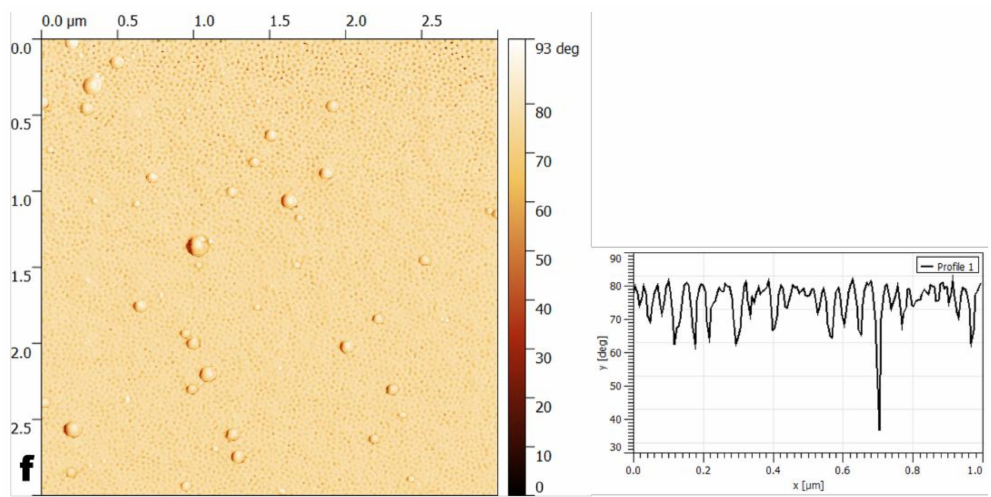
Figure 5. AFM images (3 µ m × 3 µ m) and corresponding cross-sections obtained for different copolymer films prepared under different conditions: ( a , b ) SIS casted from 1 and 3 wt% toluene solutions, respectively, at RT; ( c , d ) SIS casted from 3 wt% solutions in cyclohexane and THF, respectively, at RT; ( e , f ) SEPS and SBS, respectively, casted from 3 wt% solutions in toluene, at